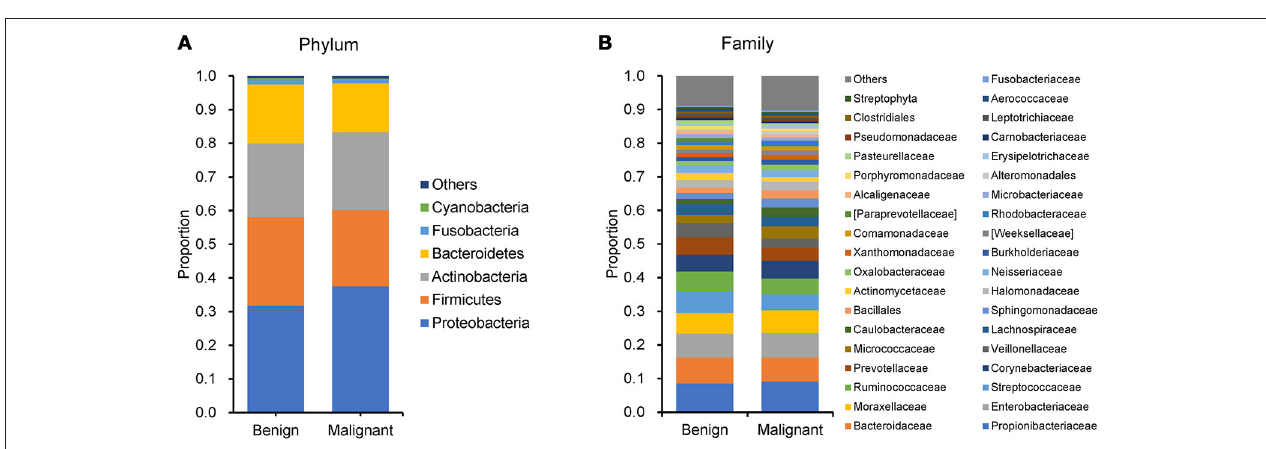
FIGURE 1 | Alpha and Beta diversity in benign and malignant breast tissue. (A) Boxplot compares Shannon index between benign and malignant ( P = 0.280, Kruskal-wilcoxs H -test); (B) PCoA plots show the clustering pattern of the two groups based on unweighted UniFrac distance ( P = 0.342, Adonis); (C) PCoA plots show the clustering pattern of the two groups based on weighted UniFrac distance ( P = 0.858, Adonis).